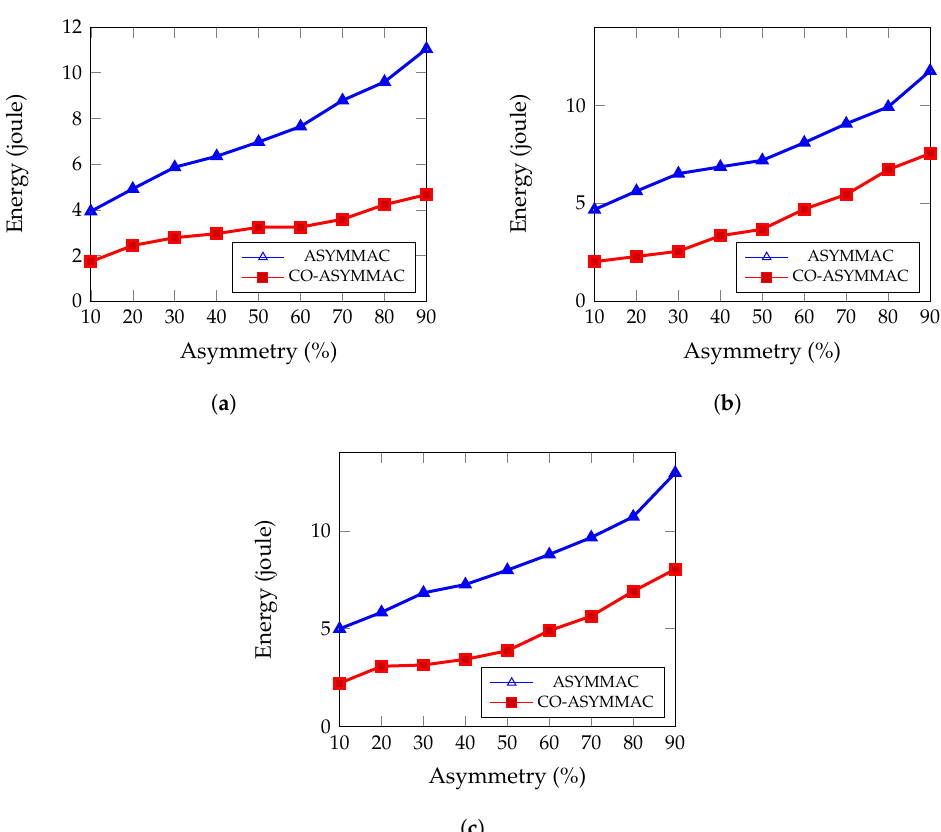
Figure 10. Per packet energy consumption: ( a ) for 27 nodes; ( b ) for 54 nodes; and ( c ) for 90